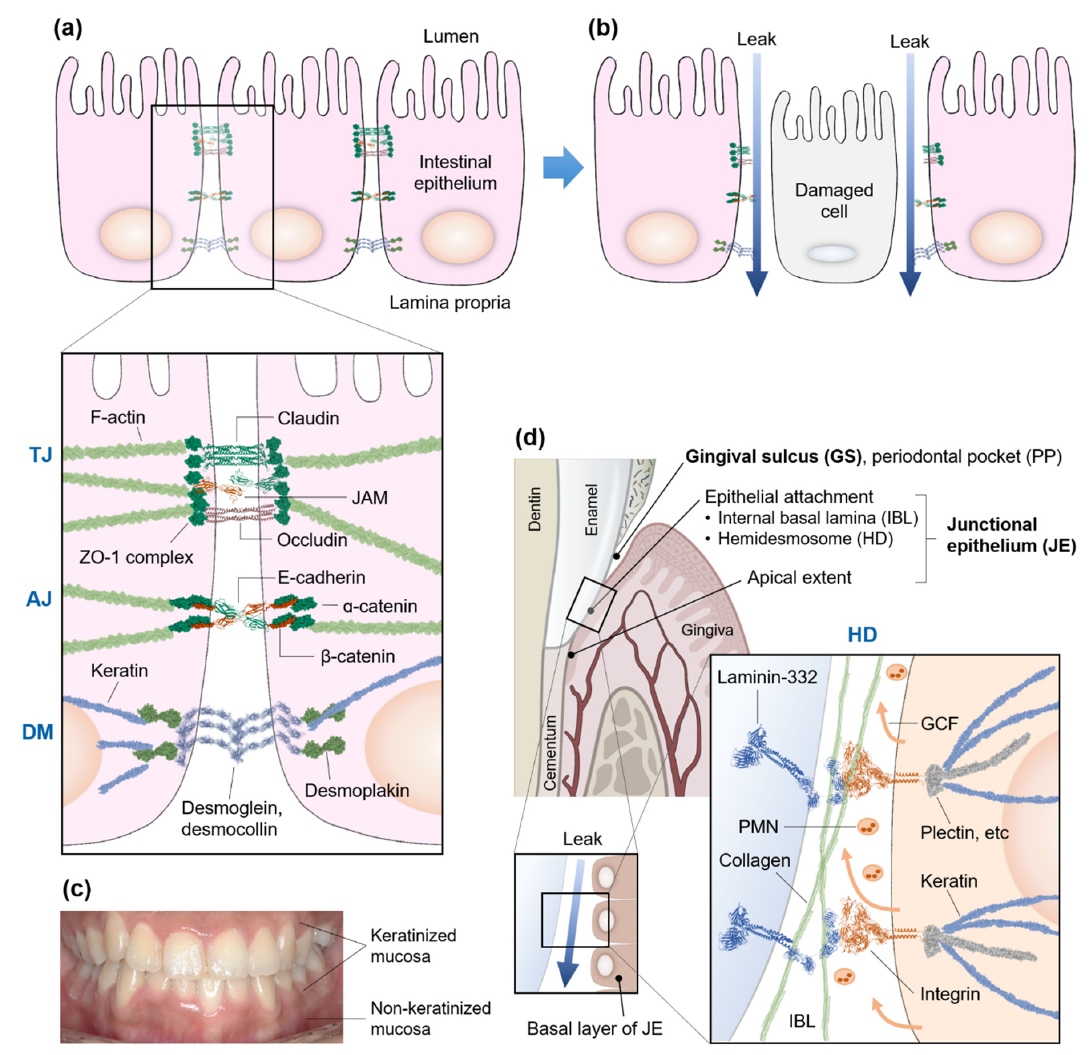
Figure 1. Schematics of differences in the cellular junctions between the intestinal and oral epithelia. ( a ) The intestinal epithelia are interconnected and communicate with each other through junctions, such as tight junction (TJ), adherence junction (AJ), desmosome (DM), and gap junction (GJ, not shown). ( b ) When these barriers are disrupted because of epithelial damages, pathogens, and chem- icals in the luminal side can leak through the damaged cellular gaps into the lamina propria (blue arrows) whereby the MALT implements immune responses, resulting in a leaky gut syndrome. ( c ) Keratinized and non-keratinized oral mucosa. ( d ) Unlike the intestinal leakage through the cell-to- cell junctions, the leakage in the oral mucosa occurs through the hemidesmosome (HD) between the basal layer of the junctional epithelium (JE) and the hard surface layer of a tooth, which is inevitably and more frequently exposed to the physical and biological challenges. The internal basal lamina (IBL), an HD interface, is inhabited with collagens and binding proteins, such as laminin-332 and integrin. The periodontal pocket (PP), a pathologically deepened gingival sulcus (GS), occurs with the detachment of the connective tissues of the gingiva from the tooth surface. The JE below the GS is ~0.15 mm wide and 1–2 mm high, remains non-keratinized and undifferentiated, and has the highest turnover rate (4–6 days) of all oral epithelia. The polymorphonuclear leukocytes (PMNs) are also secreted with gingival crevicular fluid (GCF) from the basal layer to keep a lookout for any hostile intruders. ZO-1: zonula occludens-1, JAM: junctional adhesion molecule.